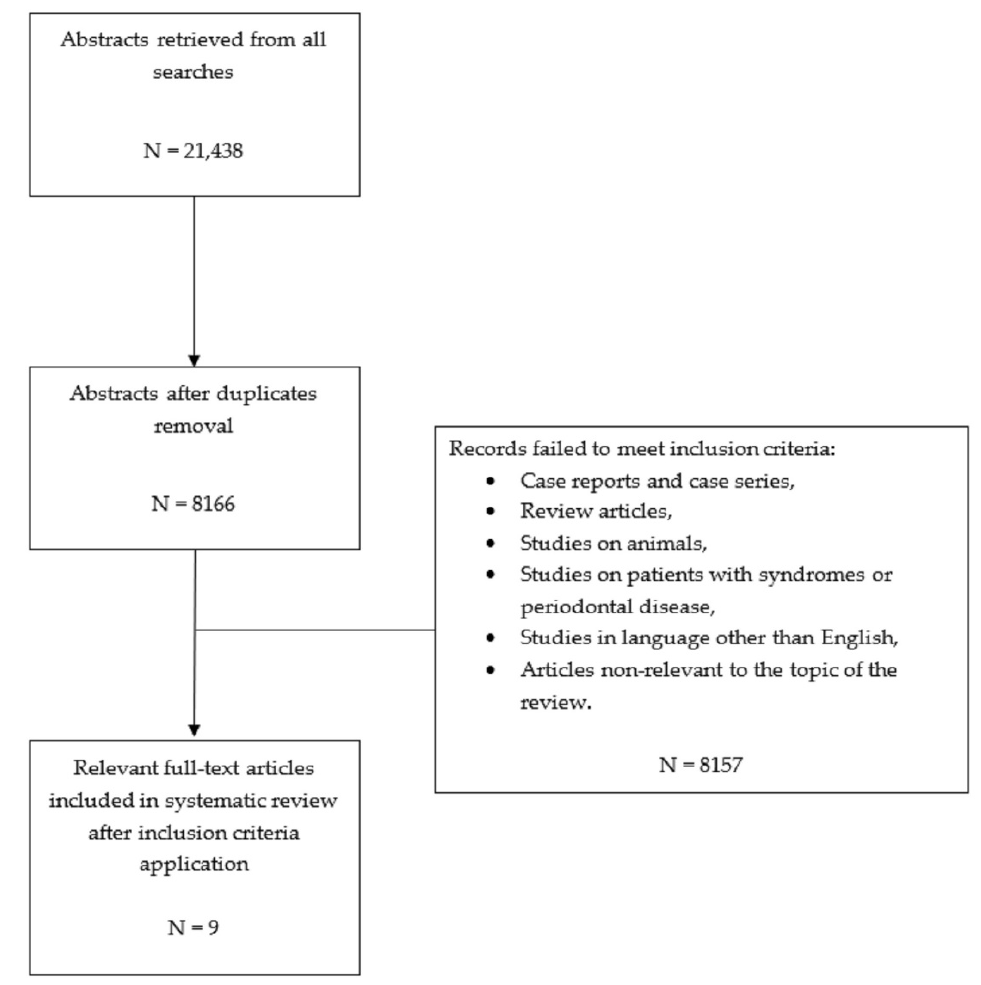
Figure 1. The PRISMA flow chart.